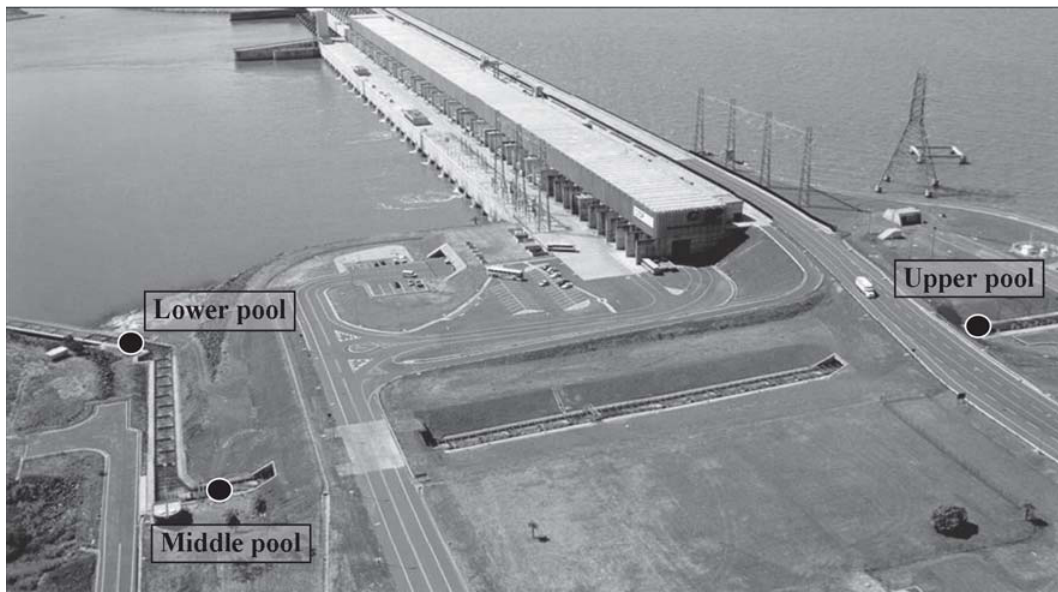
Fig. 2. Fish ladder and the powerhouse of Engenheiro Sergio Motta